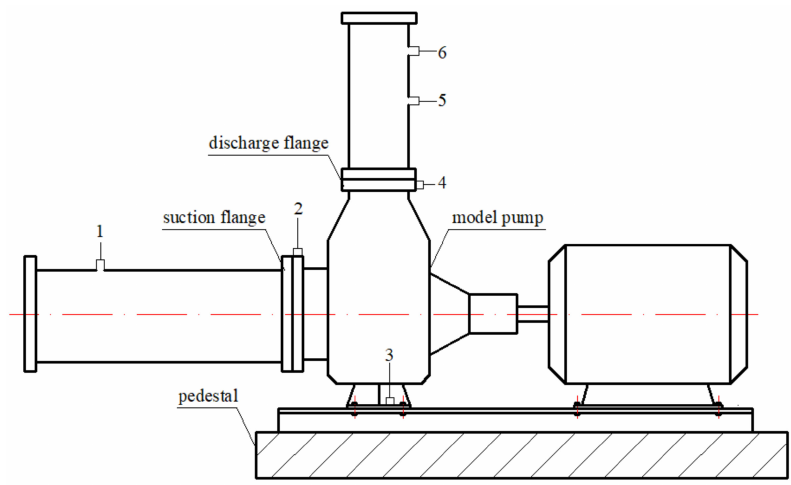
Figure 4. Installation position of sensors: 1. inlet pressure sensor, 2. acceleration sensor at pump inlet, 3. acceleration sensor at pump foot, 4. acceleration sensor at pump outlet, 5. outlet pressure pulsation sensor, 6. inlet pressure